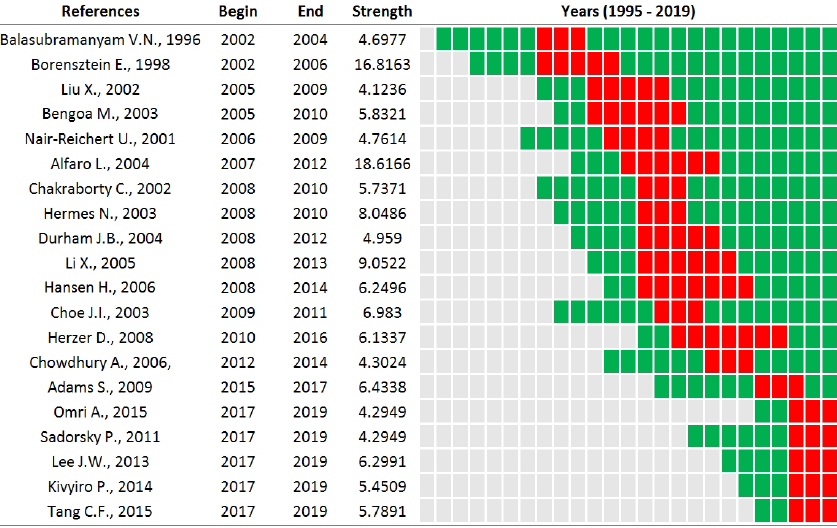
Figure 6. Top articles with citation burst between 1995–2019 (source: Scopus, using Citespace, version 5.7.R2 (Chen,